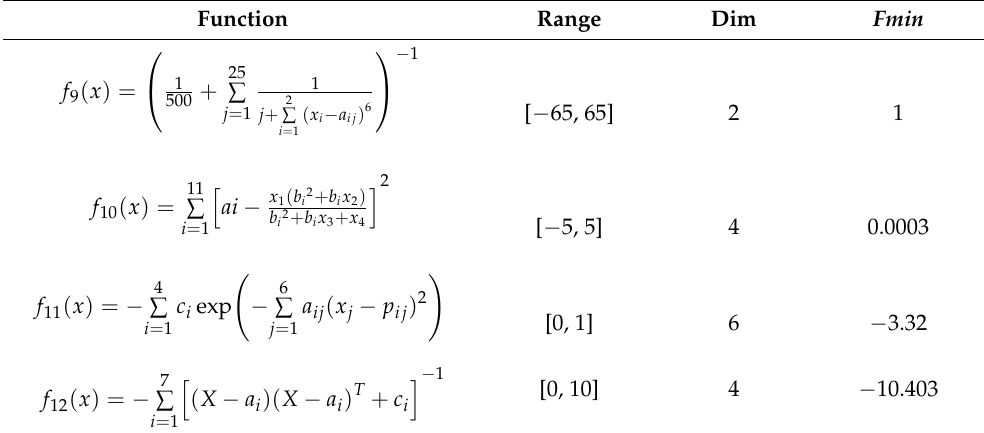
Table 3. Fixed-dimension test functions.